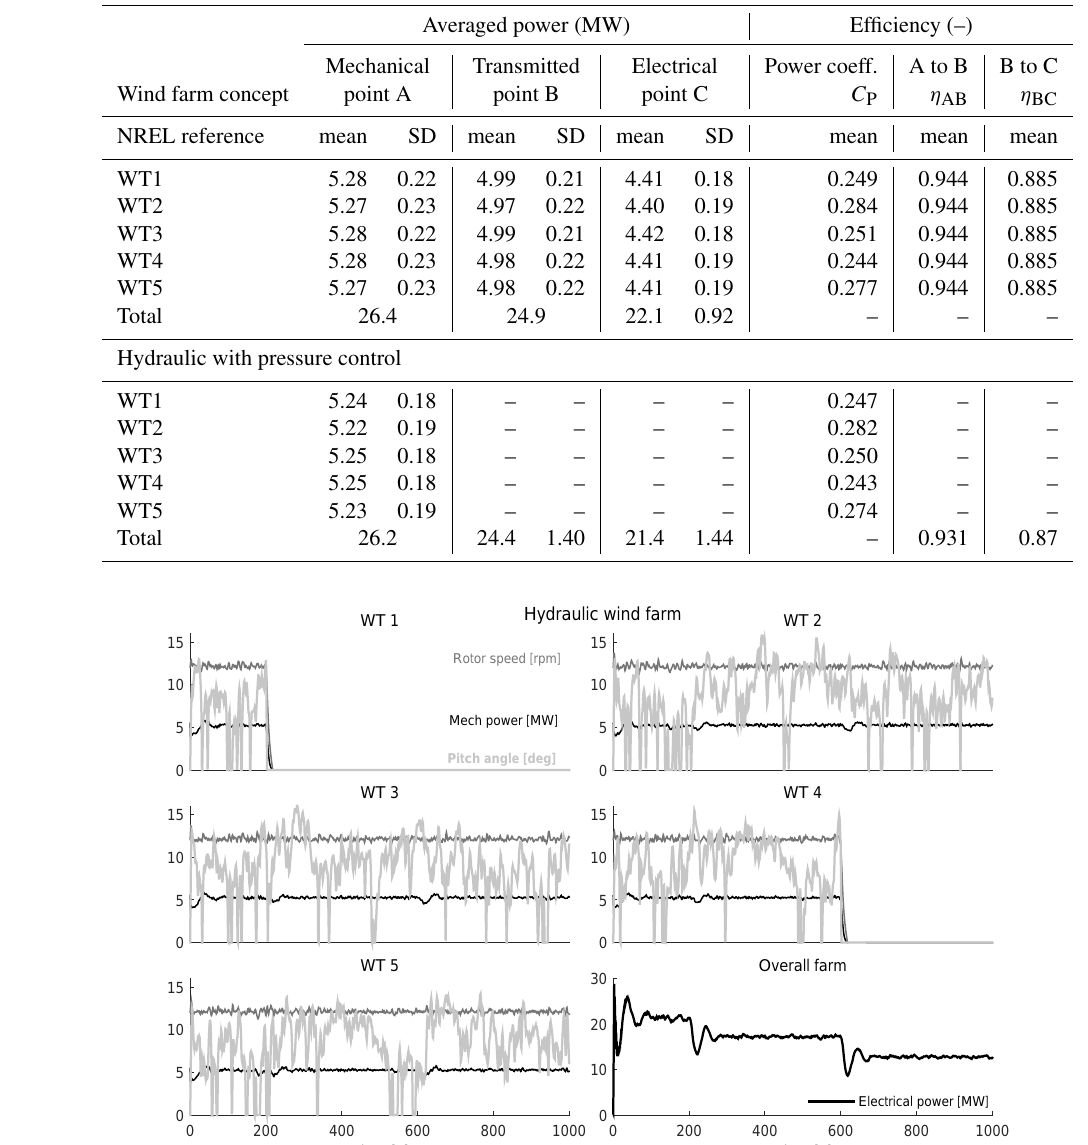
Table 4. Performance overview of time domain results for above rated conditions.